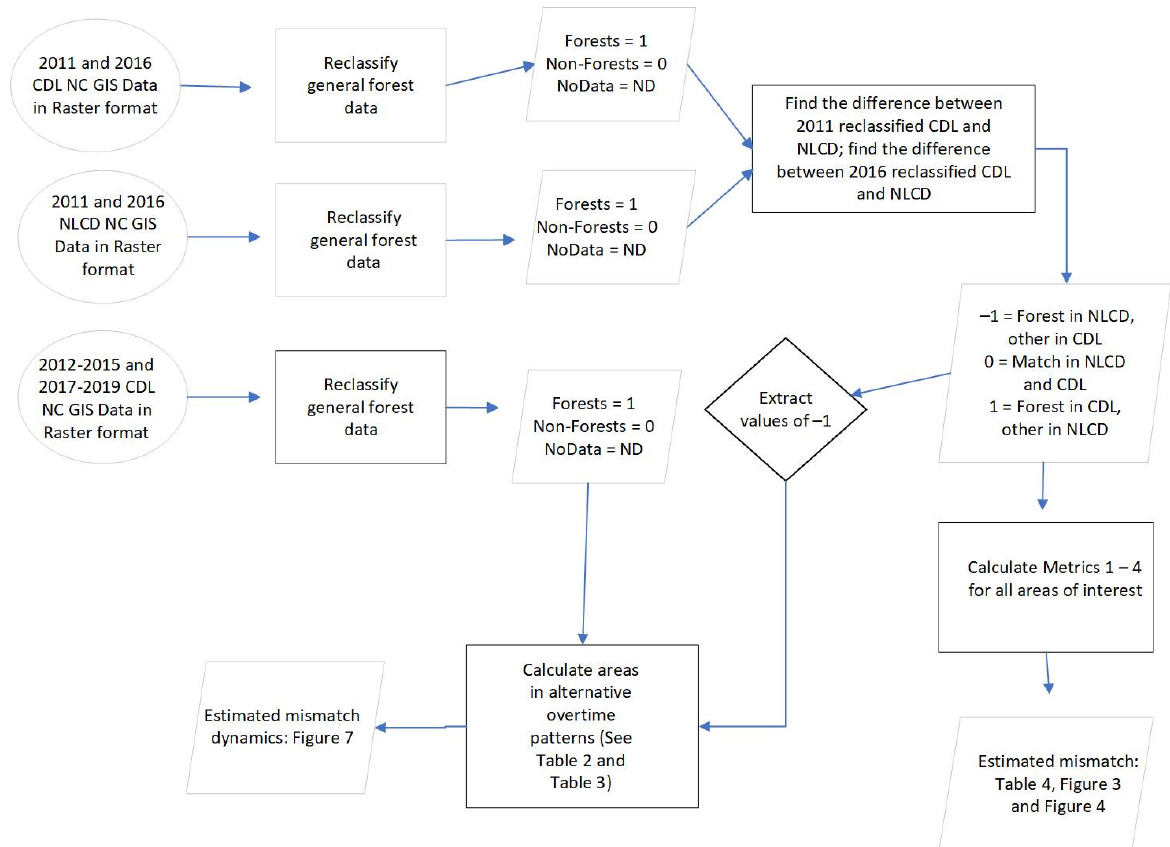
Figure 2. Flow diagram of data development and analysis.